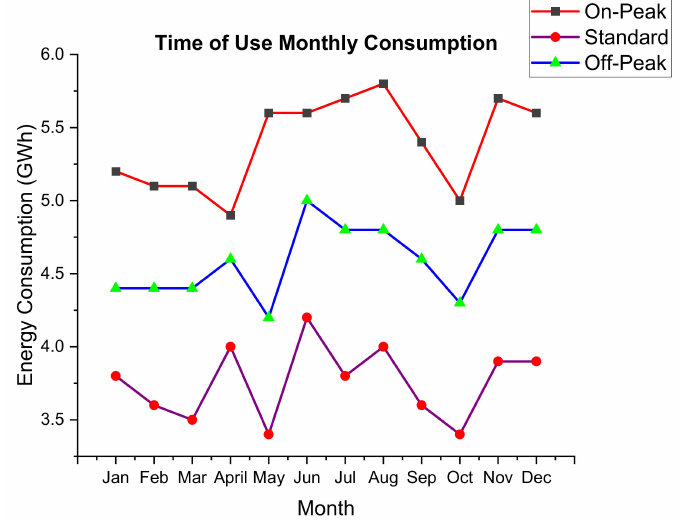
Figure 6. Time of Use monthly consumption of the Mimosa mine in